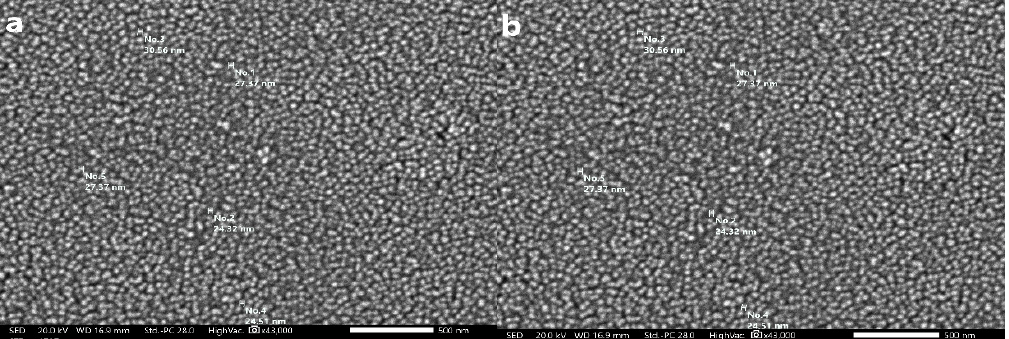
Fig. 6. SEM photographs of USeNPS Figure 6. SEM photographs of USeNPS (500 nm) ( a , b ) showing different particle